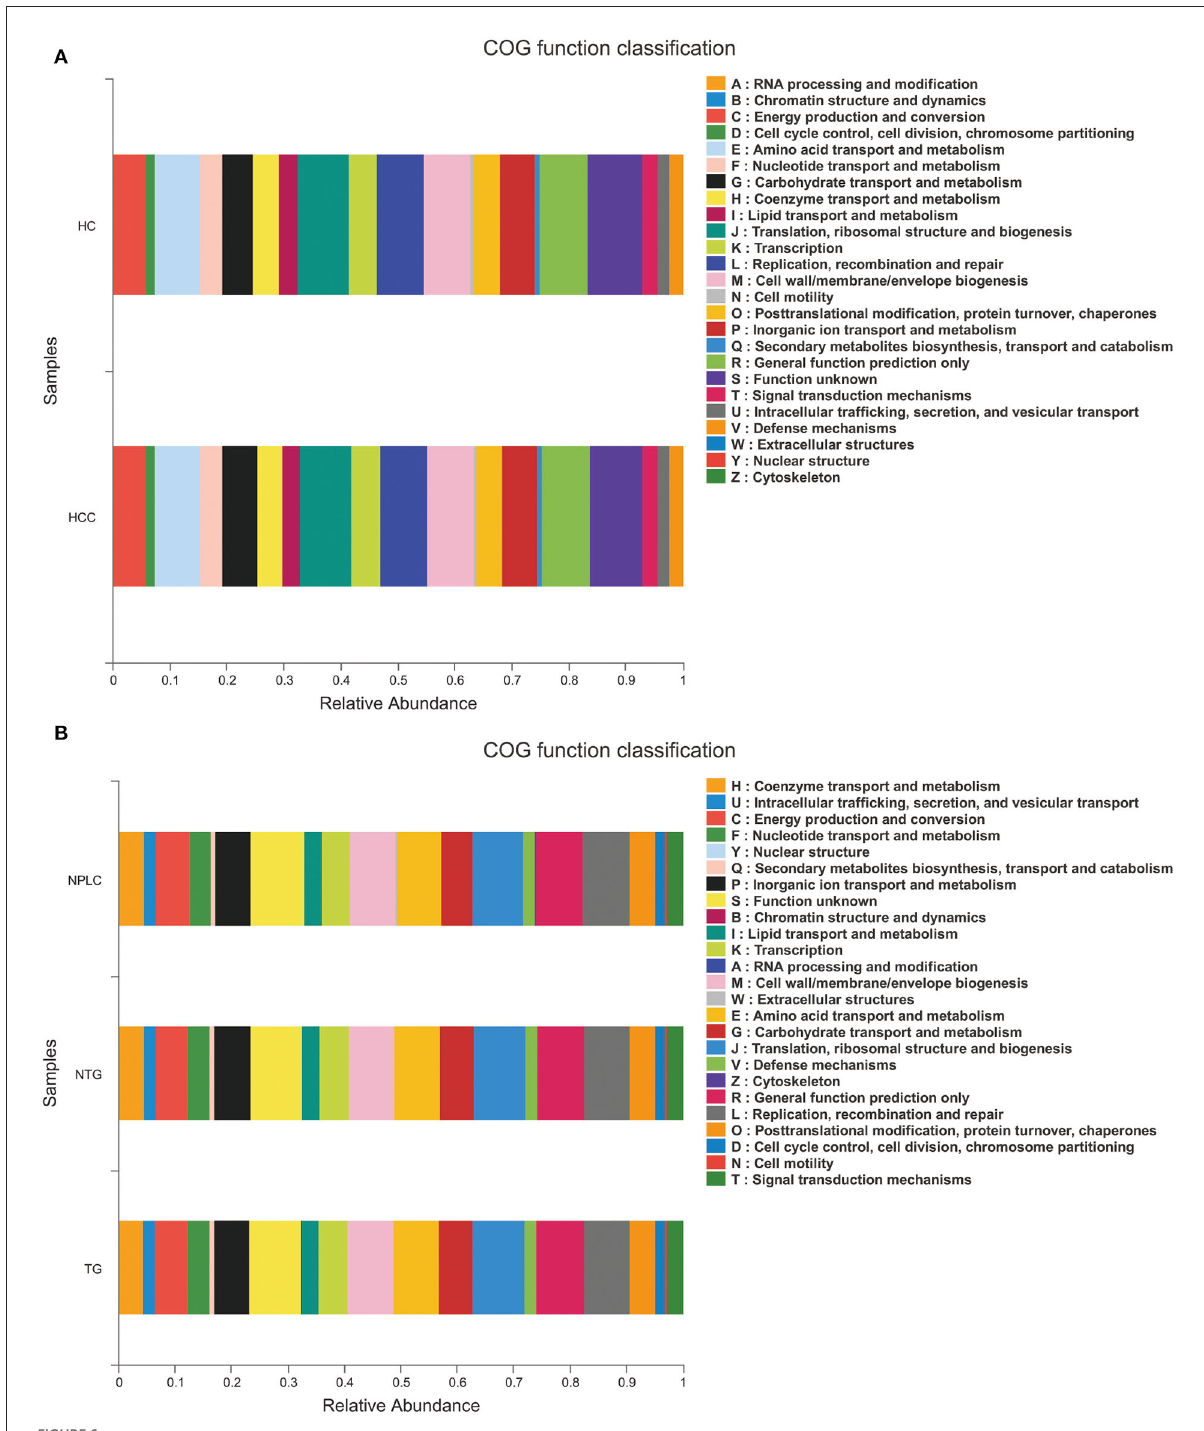
FIGURE6 Functional predictions. (A) The compositions of COG function in the HC and PLC groups. (B) The compositions of COG function in the HC, LTG, and LNTG groups. (PLC represents primary liver cancer, LTG represents liver cancer with thick or greasy coating, LNTG represents liver cancer with non-thick or greasy coating, and HC represents healthy control).